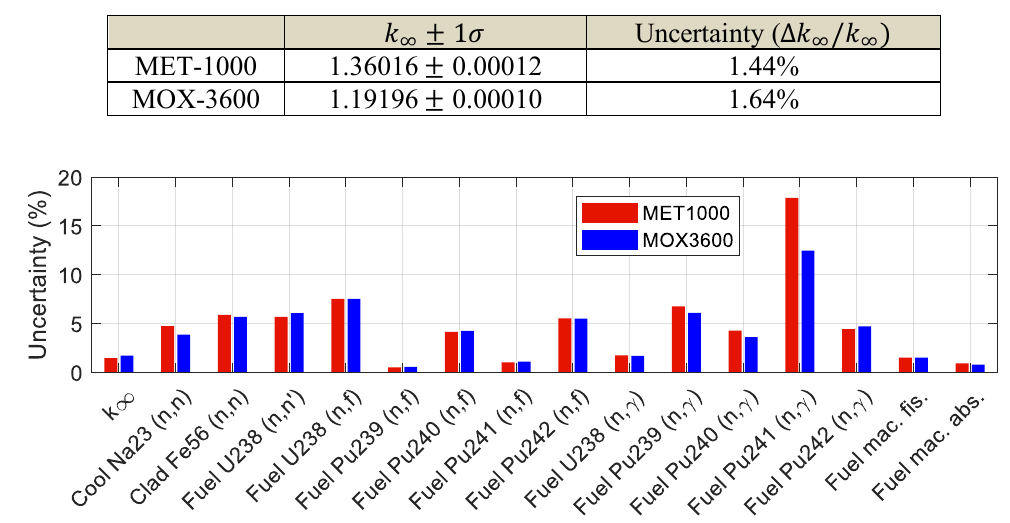
Figure 2. Uncertainty summary of pin-cell